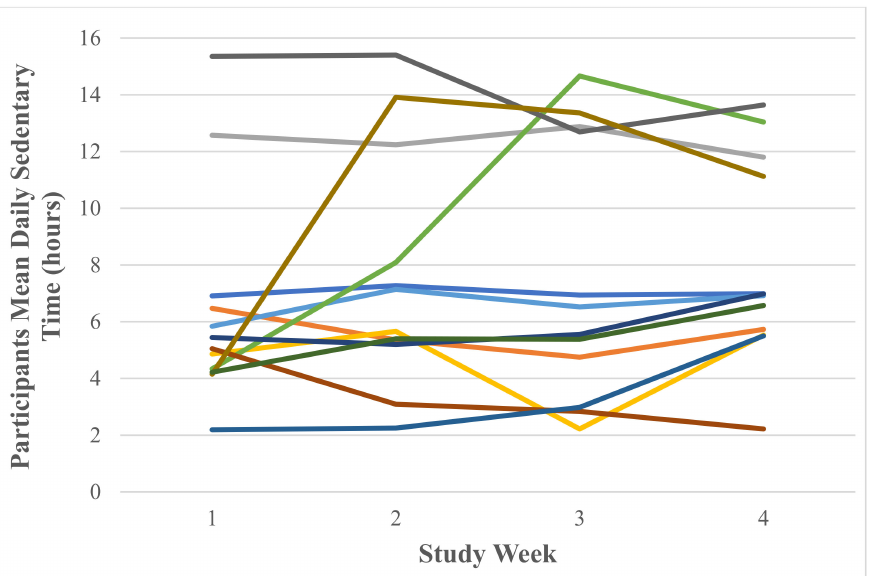
Figure 5. Individual participants’ mean daily sedentary time (hours) as recorded via the Fitbit Charge 4 activity tracker (each coloured line represents one of the 12